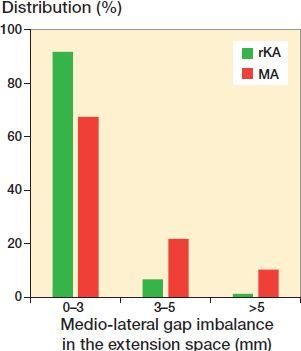
Distribution of medio-lateral gap imbalance in the extension space for rKA and MA techniques (p < 0.001).